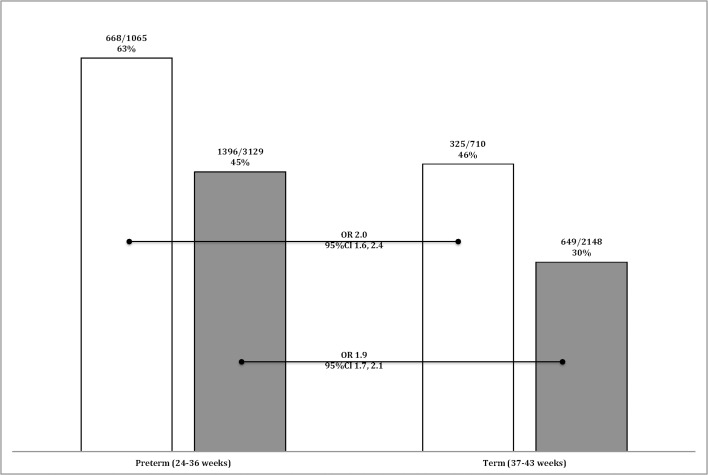
Prevalence of ever wheezing for the whole study population.Bars denote the percentage of children having ever wheezed who have a family history of atopy (white bars) or not (black bars) and for both gestational groups, preterm or term.